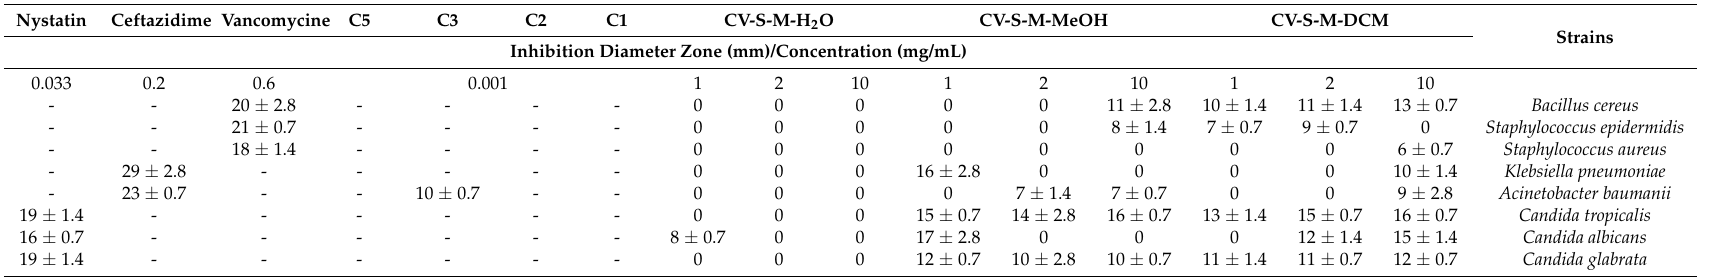
Table 5. Antimicrobial effects of C. villosa stems crude extracts, the isolated compounds, the antibiotics and the antifungal (diameter of the well is 6 mm). All values are expressed as mean of duplicate ±